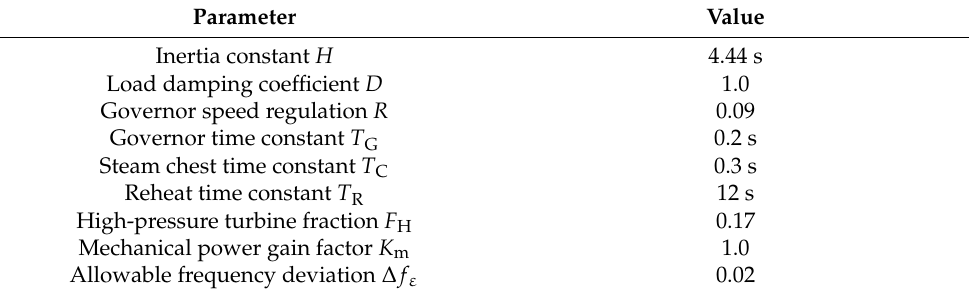
Table 1. Parameters of the equivalent-system frequency regulation model.